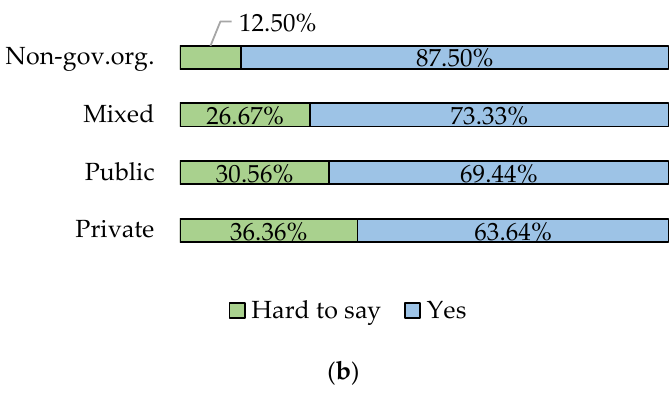
Figure 6. The opinion in ERIH sites whenever the transformation of an industrial plant to a tourist attraction process should be shared as OI in general ( a ) and with differentiation among various ownership forms ( b ).